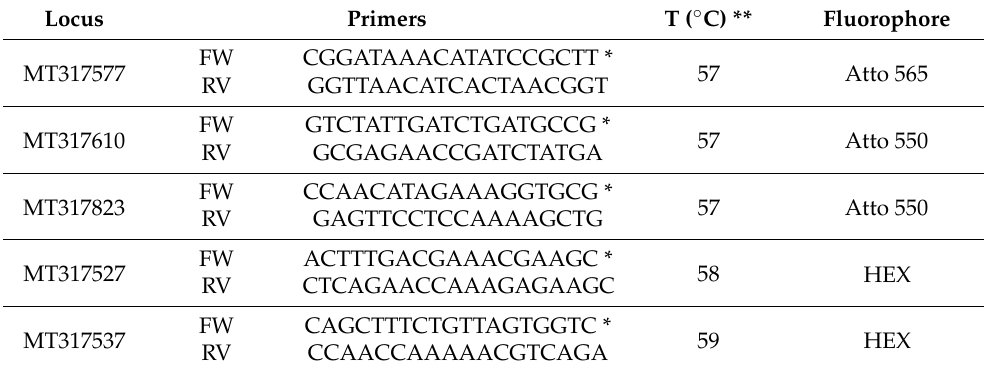
Table 1. SSR Loci Used for Accessions Identification. Locus Primers T ( ◦ C)